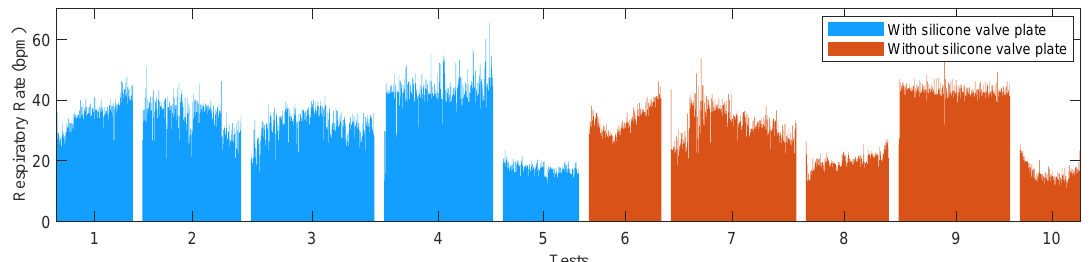
Figure 14. The respiratory rates of 10 tests measured by the sensor in the experiments of movement mode.